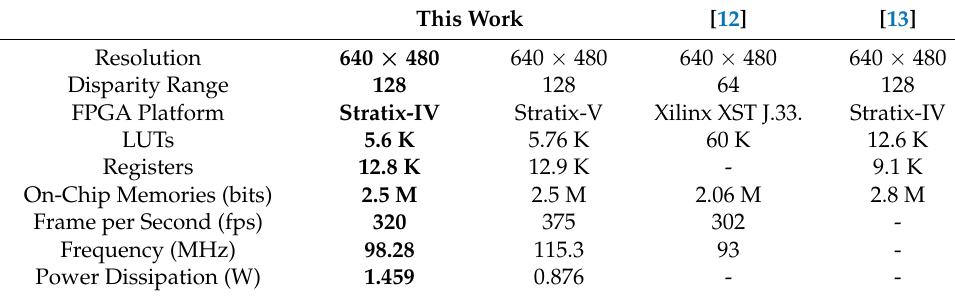
Table 1. Comparison of FPGA resources (-: not